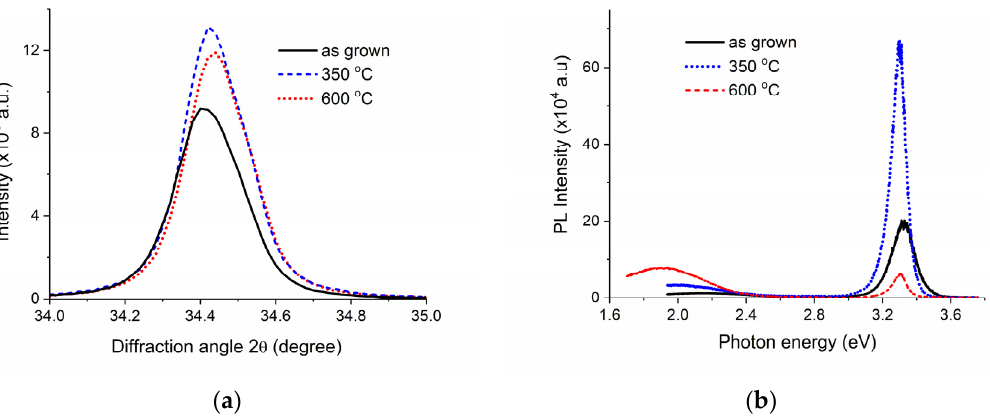
Figure 2. ( a ) XRD spectra ( b ) PL spectra of ZnO nanorods before and after annealing at different temperatures.